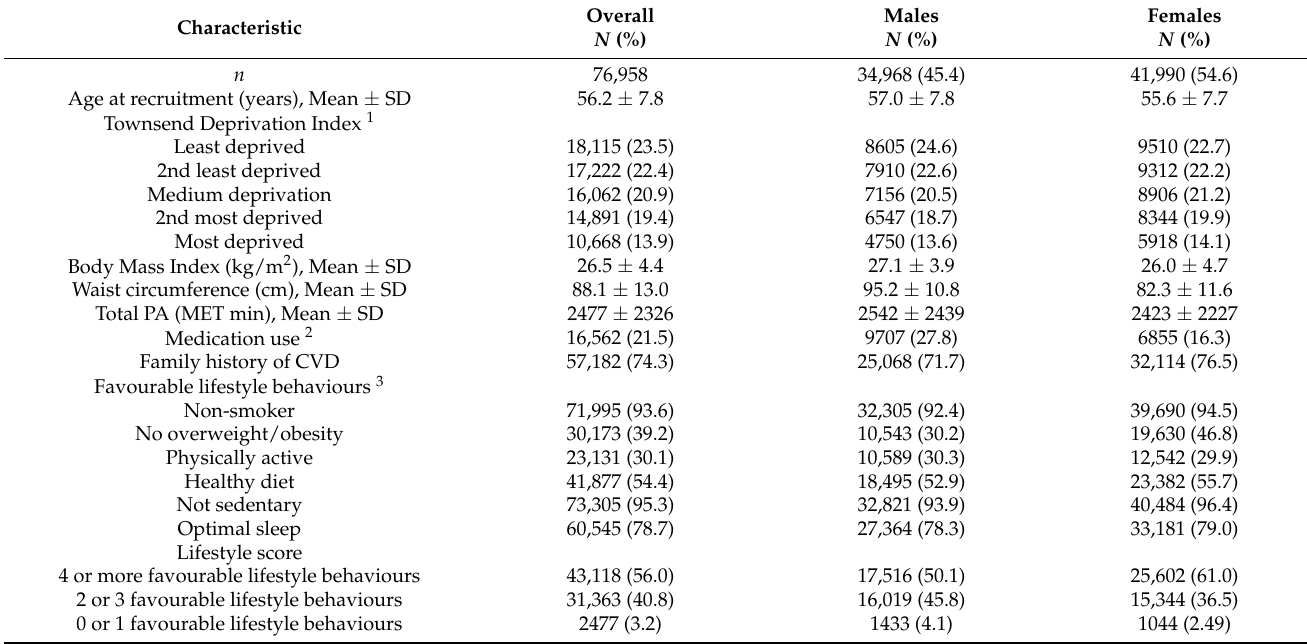
Table 1. Characteristics of participants at baseline in the UK